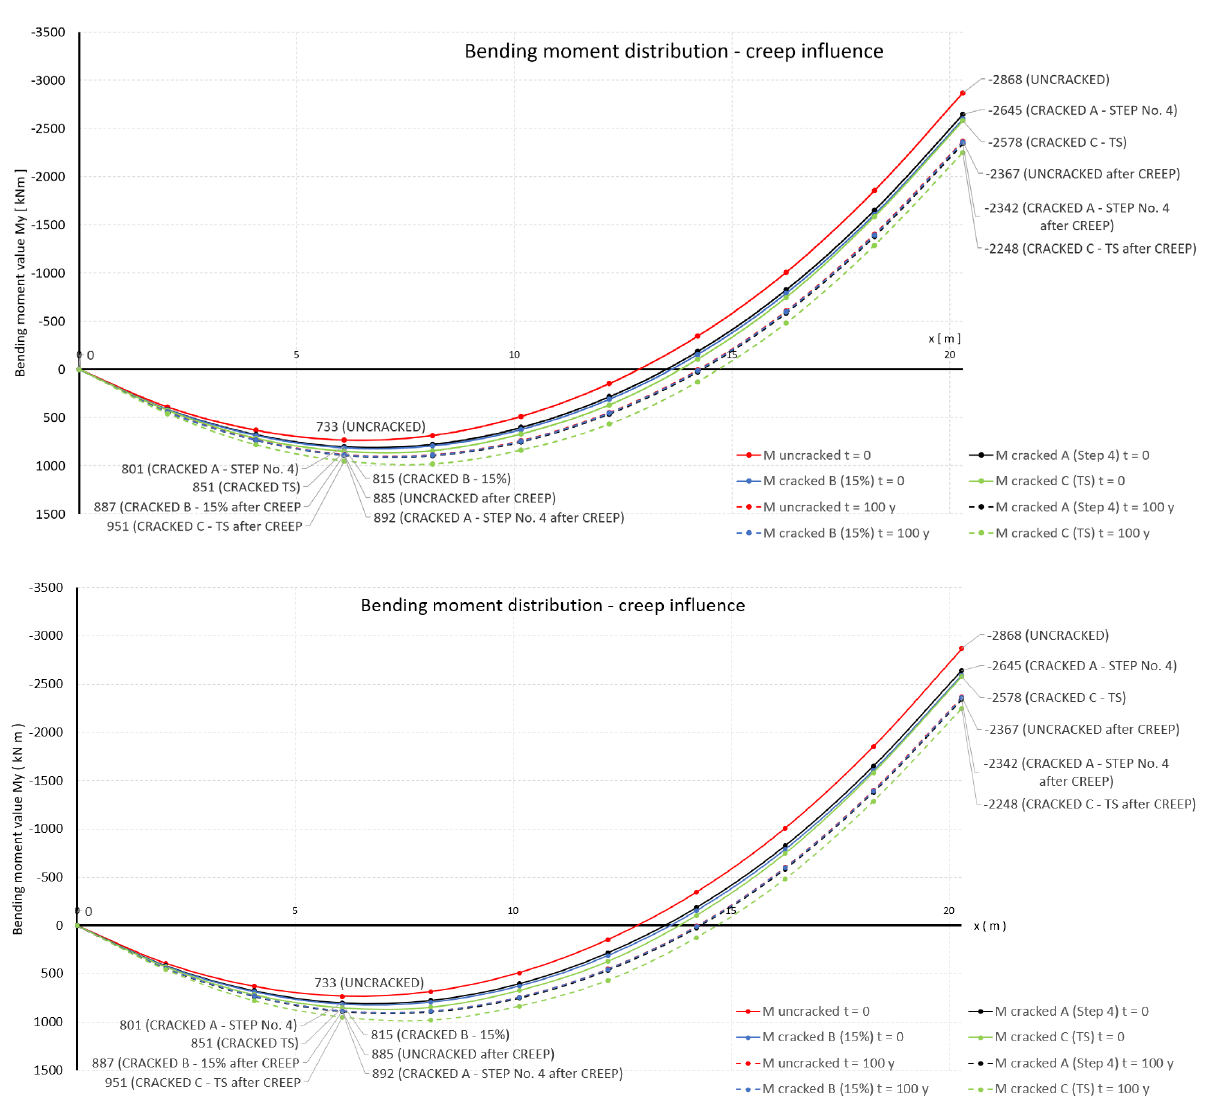
Figure 20: Influence of creep on the bending moment distribution in dependence of the assumed approach (A, B, C). Continuous lines – bending moments without creep, dotted lines – after creeping of